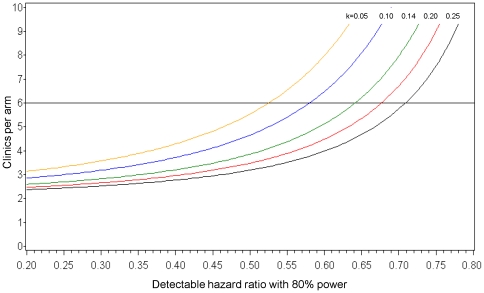
Detectable hazard ratio as a consequence of utilizing routine HIV-1 viral load monitoring at varying between-clinic coefficients of variation.Calculation assumes a historical 18 month post-ART mortality rate of 15.6 per 100 years (140 patients remaining per clinic).